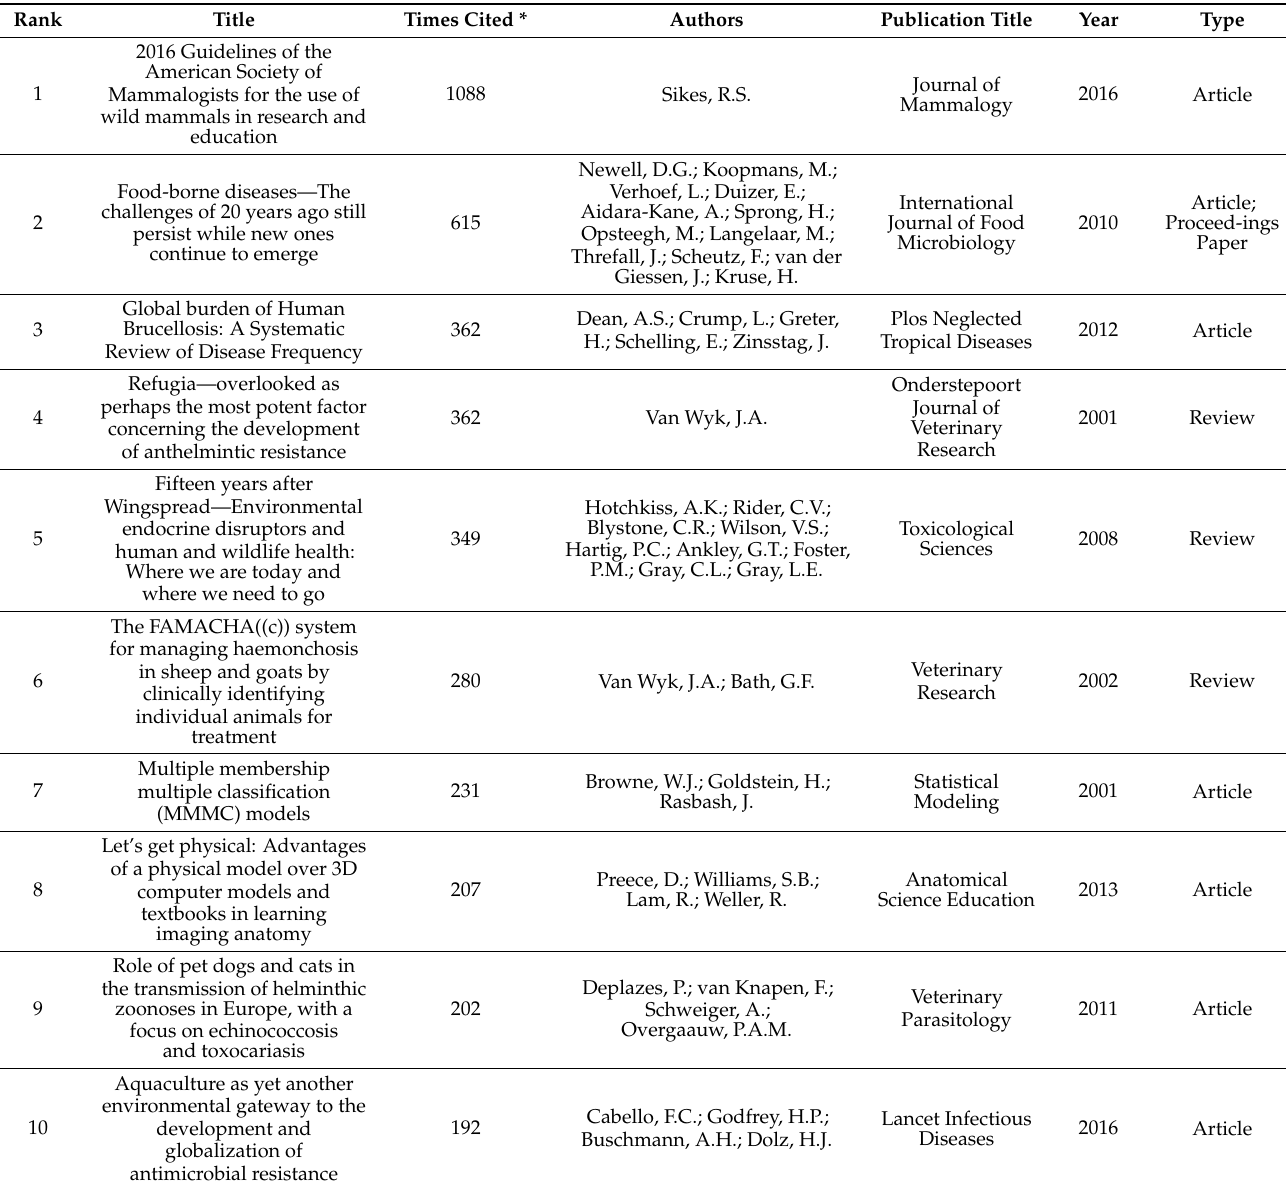
Table 1. The top 10 highly cited publications in veterinary education (VEPs) from 2000 to